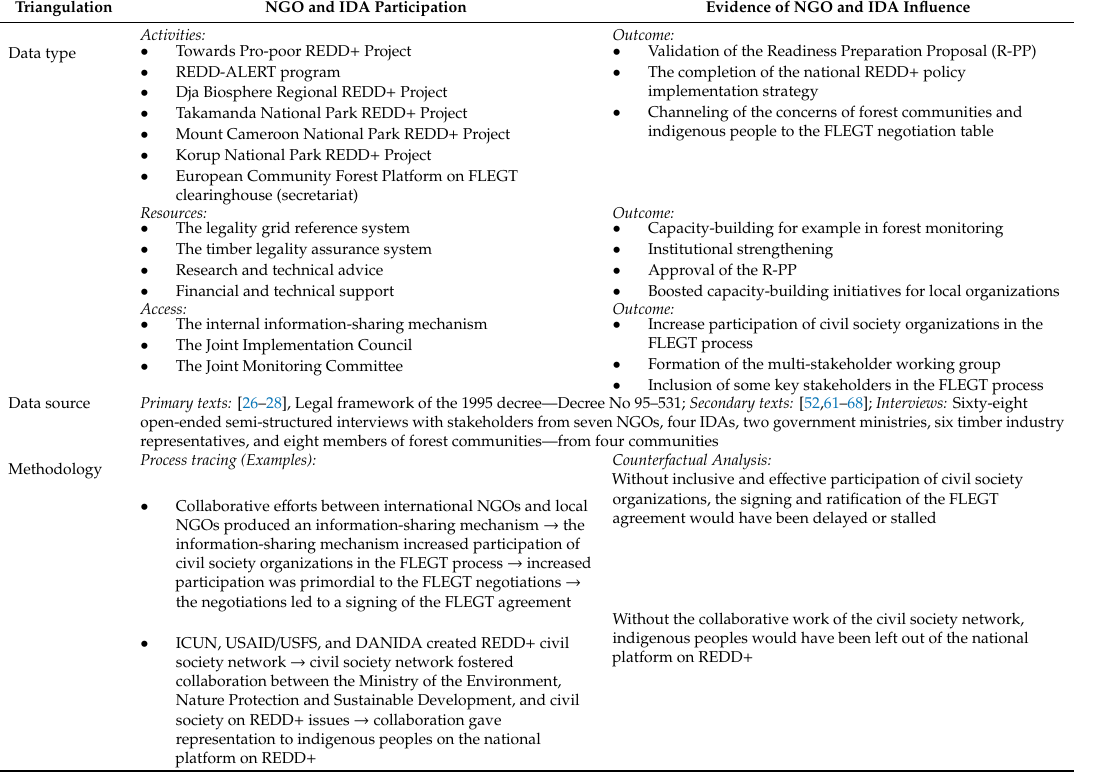
Table 2. Systematic presentation of the facts of the